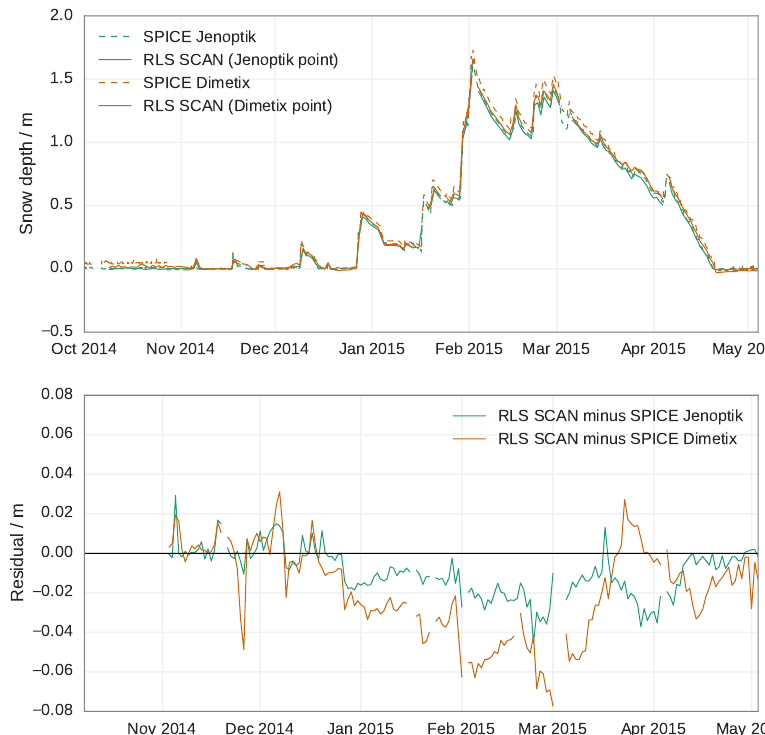
Figure 9. Evaluation of the RLS scan mode against SPICE laser meters.